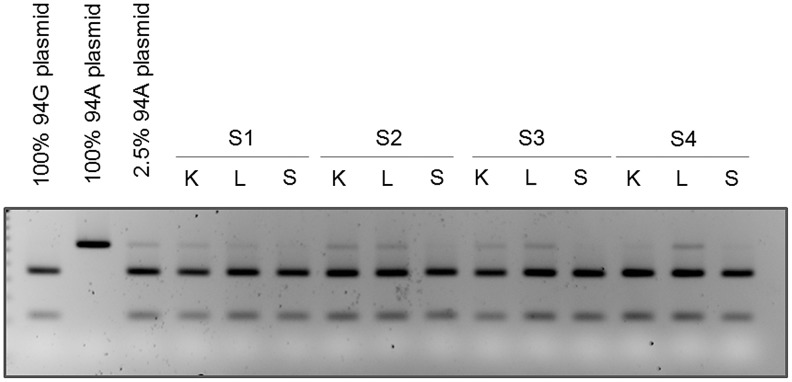
Mutation at position 94 is verified by RFLP analysis.DNA isolated from kidney (K), liver (L), and spleen (S) from subjects 1, 2, 3 and 4 were subjected to PCR and RFLP analysis. The presence of the mutation at position 94 is seen as the presence of the upper (uncut) band by gel electrophoresis. RFLP analysis of PCR products from wild type (94G), mutant (94A), and mixed (2.5% 94A) plasmid DNA are also loaded for comparison.